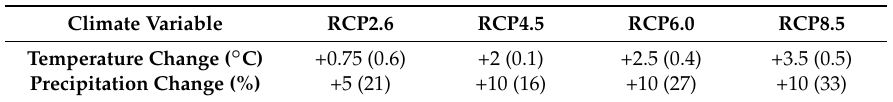
Table 2. Projected future climate change at Lake Babati based on CMIP5 ensemble mean (2080–2100). The values in brackets represent the standard deviation.